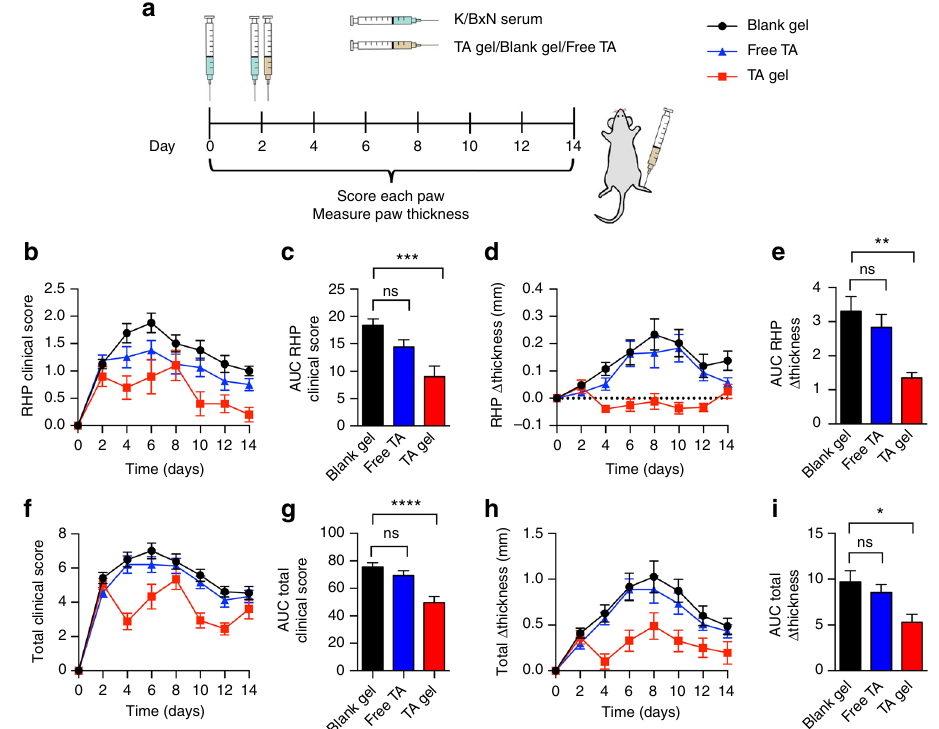
Fig. 5 Local delivery of TA encapsulated in TG-18 hydrogel improves therapeutic ef fi cacy compared to free TA in a mouse model of IA. a Experimental outline: Arthritis was induced by i.p. injection of 37.5 µ l K/BxN serum on day 0 and day 2. Immediately after the second dose of K/BxN serum, TA-loaded TG-18 hydrogel (TA gel, 20 mg TA/ml, 4 µ l), free TA (20 mg TA/ml, 4 µ l), or blank TG-18 hydrogel (Blank gel, 4 µ l) were injected into the right hindpaw. Every other day, arthritis severity was scored clinically and paw swelling was measured with calipers. b , c RHP clinical score curves and their AUCs (*** P < 0.001). d , e Change in RHP thickness curves and their AUCs (** P < 0.01). f , g Total clinical score curves and their AUCs (**** P < 0.0001). h , i Change in total paw thickness curves and their AUCs (* P < 0.05). P- values were determined by one-way Anova with Tukey ’ s post hoc analysis. Data are means ± SEM ( n = 18 – 20 mice per group, data were pooled from three independent